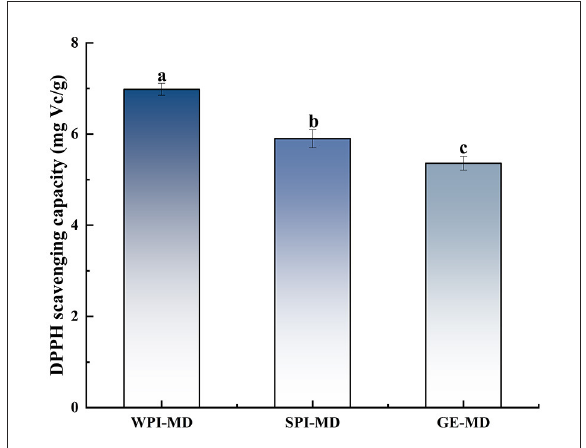
FIGURE5 The DPPH free radical scavenging ability of microcapsules. Different superscript letters in the graph indicate significant differences between means ( P <